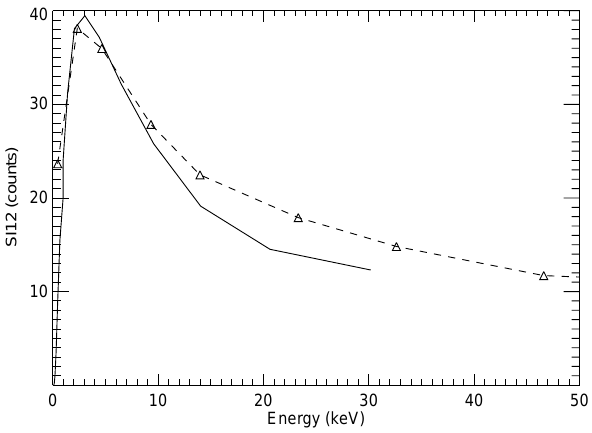
Fig. 5. Dependence of the calculated SI12 count rate (counts/pixel over 5s integration period) on the mean proton energy for a unit (1mW/m 2 ) incident proton energy flux (second efficiency curve). The solid line is for monoenergetic proton precipitation and the dashed line with triangles for a kappa-function distribution.